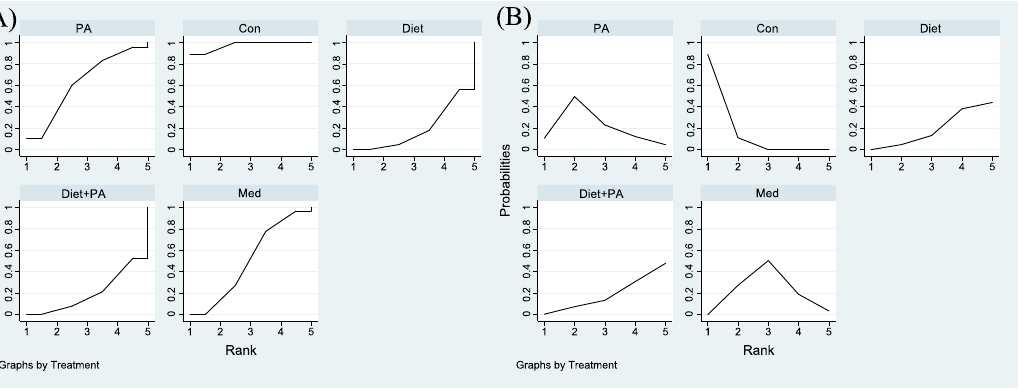
Figure 6. Surface Under the Cumulative Ranking for GWG ( A ). Rankograms for GWG ( B ) were derived from relevant SUCRA values for various regimens. Abbreviations: physical activity, PA; control, Con; medication, Med.